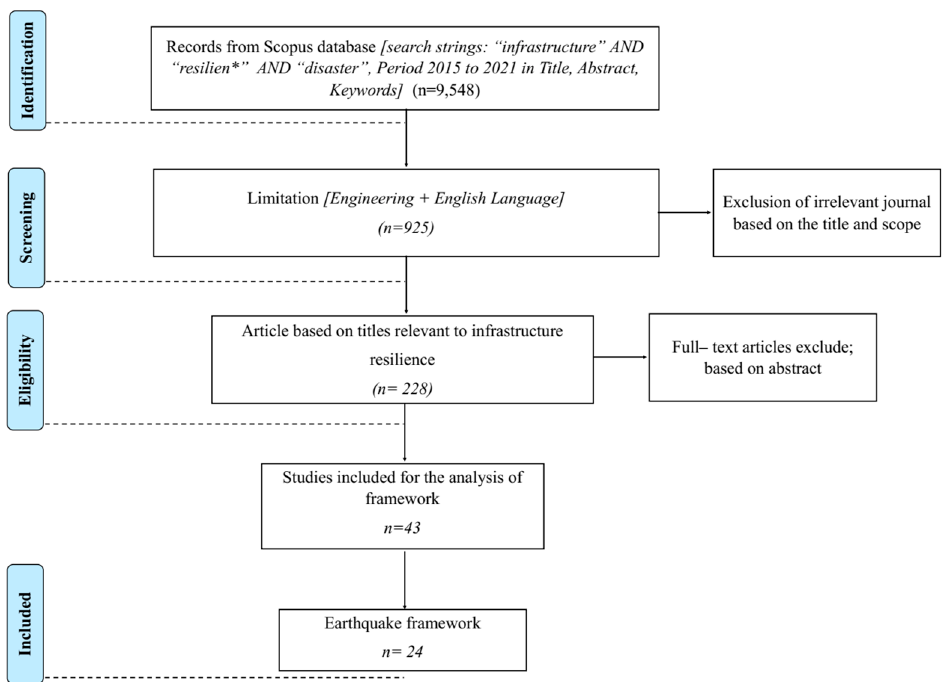
Figure 2. PRISMA flowchart to identify and select studies relevant to infrastructure resilience frameworks.